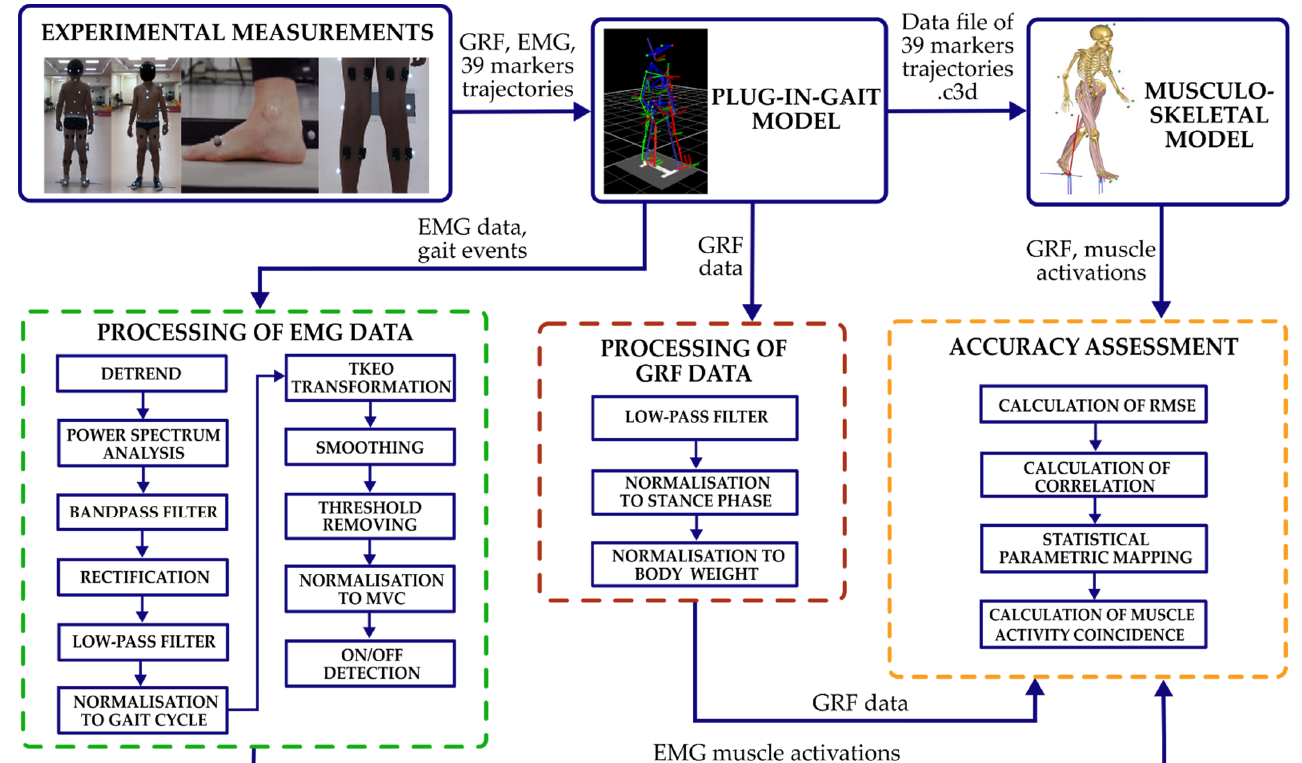
Figure 1. Procedures to conduct the study.